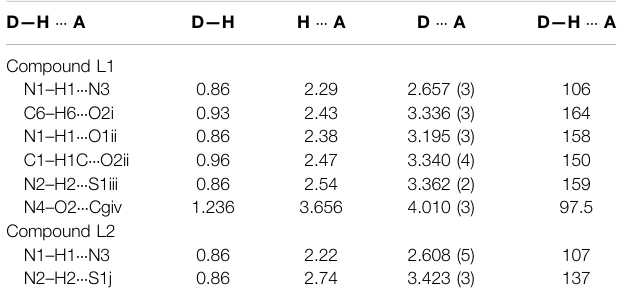
TABLE 3 | Hydrogen-bond geometry for compounds L1 and L2 (Å, o).